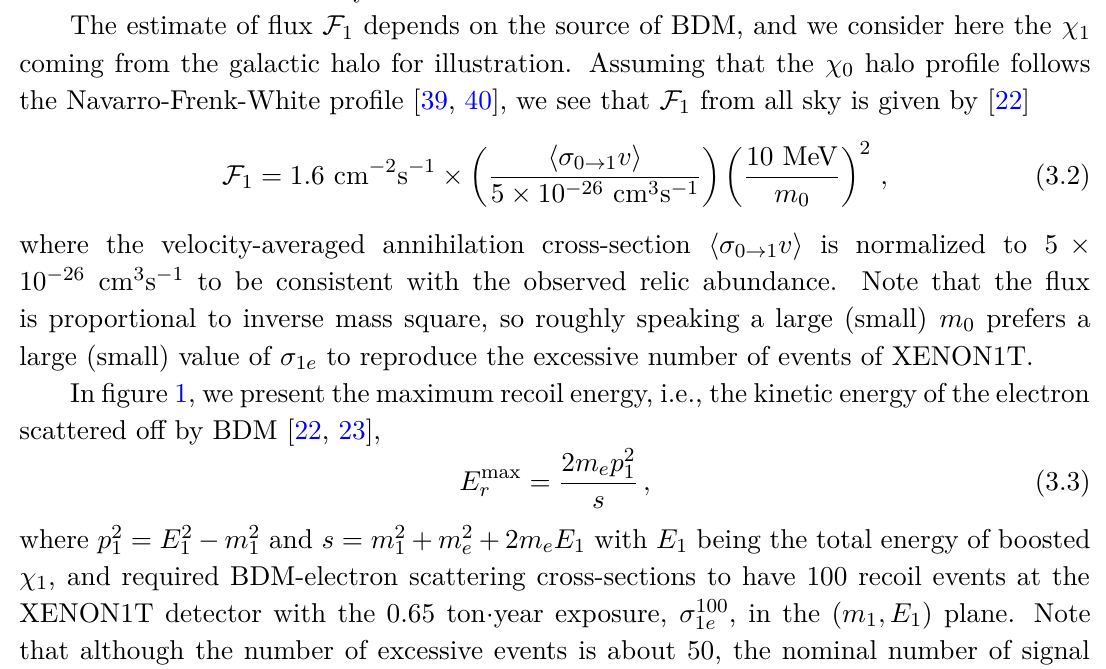
(solid colored r